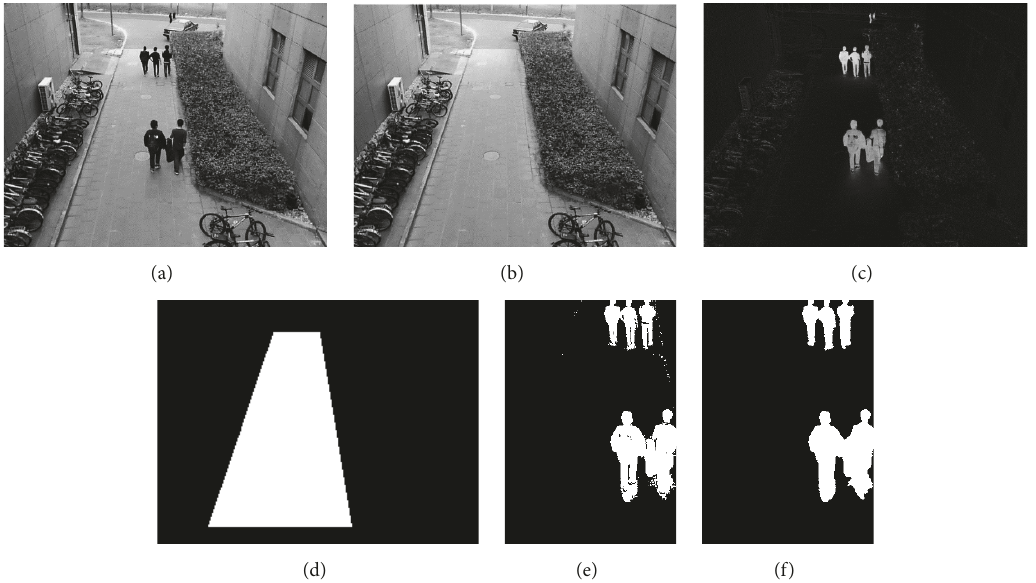
Figure 2: Visible light image processing (a) Original image. (b) Background image. (c) Background difference result. (d) ROI mask. (e) Foreground image. (f) Final